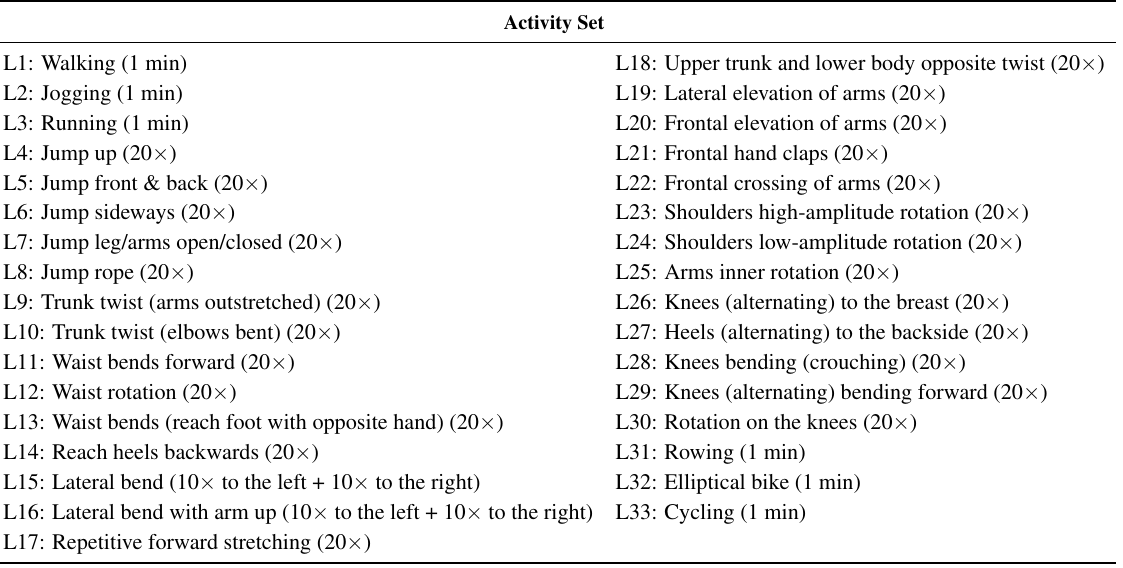
Table 1. Warm up, cool down and fitness exercises considered for the activity set. In brackets are the number of repetitions (N × ) or the duration of the exercises